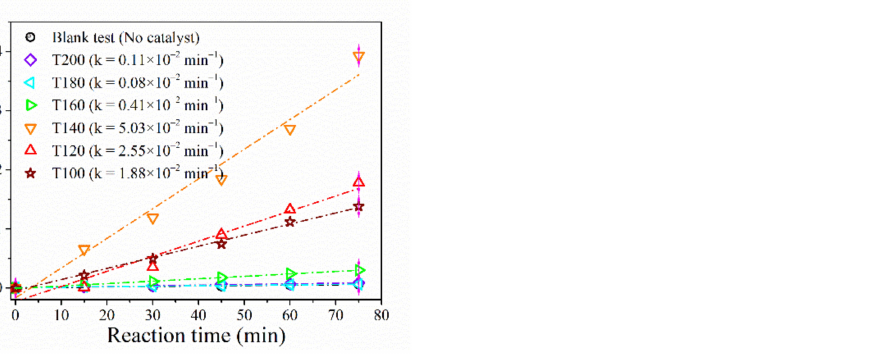
Figure A3. Plot of ln(C/C 0 ) with UV irradiation time for the photocatalysis of MB by TiO 2 samples. In Figure A4, values of the gap energy for direct transitions derived from the reflectance spectra of all TiO 2 NP samples are shown. Figure A4 inset shows the (F(R)h ν ) 2 against photon energy (eV) for a direct transition, the intercept of the tangent (F(R)h ν ) 2 = 0 of the Tauc plot gives a band-gap energy of 3.21 eV for T140.